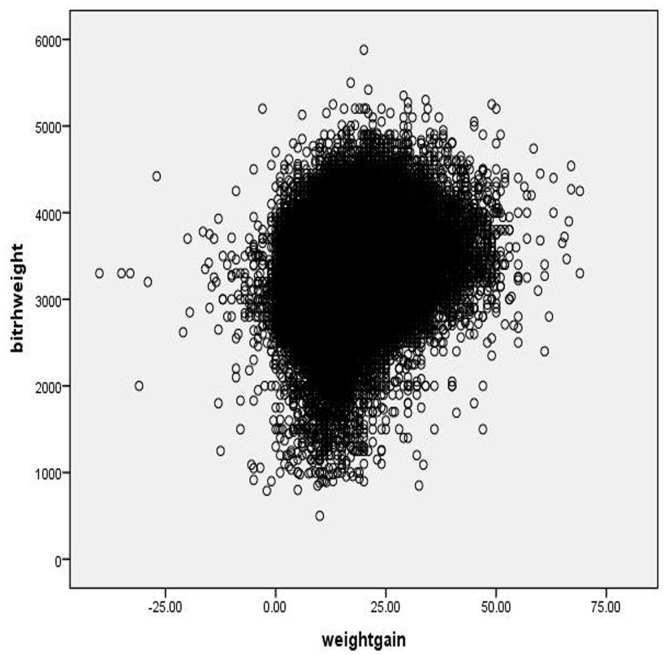
Scatter diagram of birth weight and weight gain.